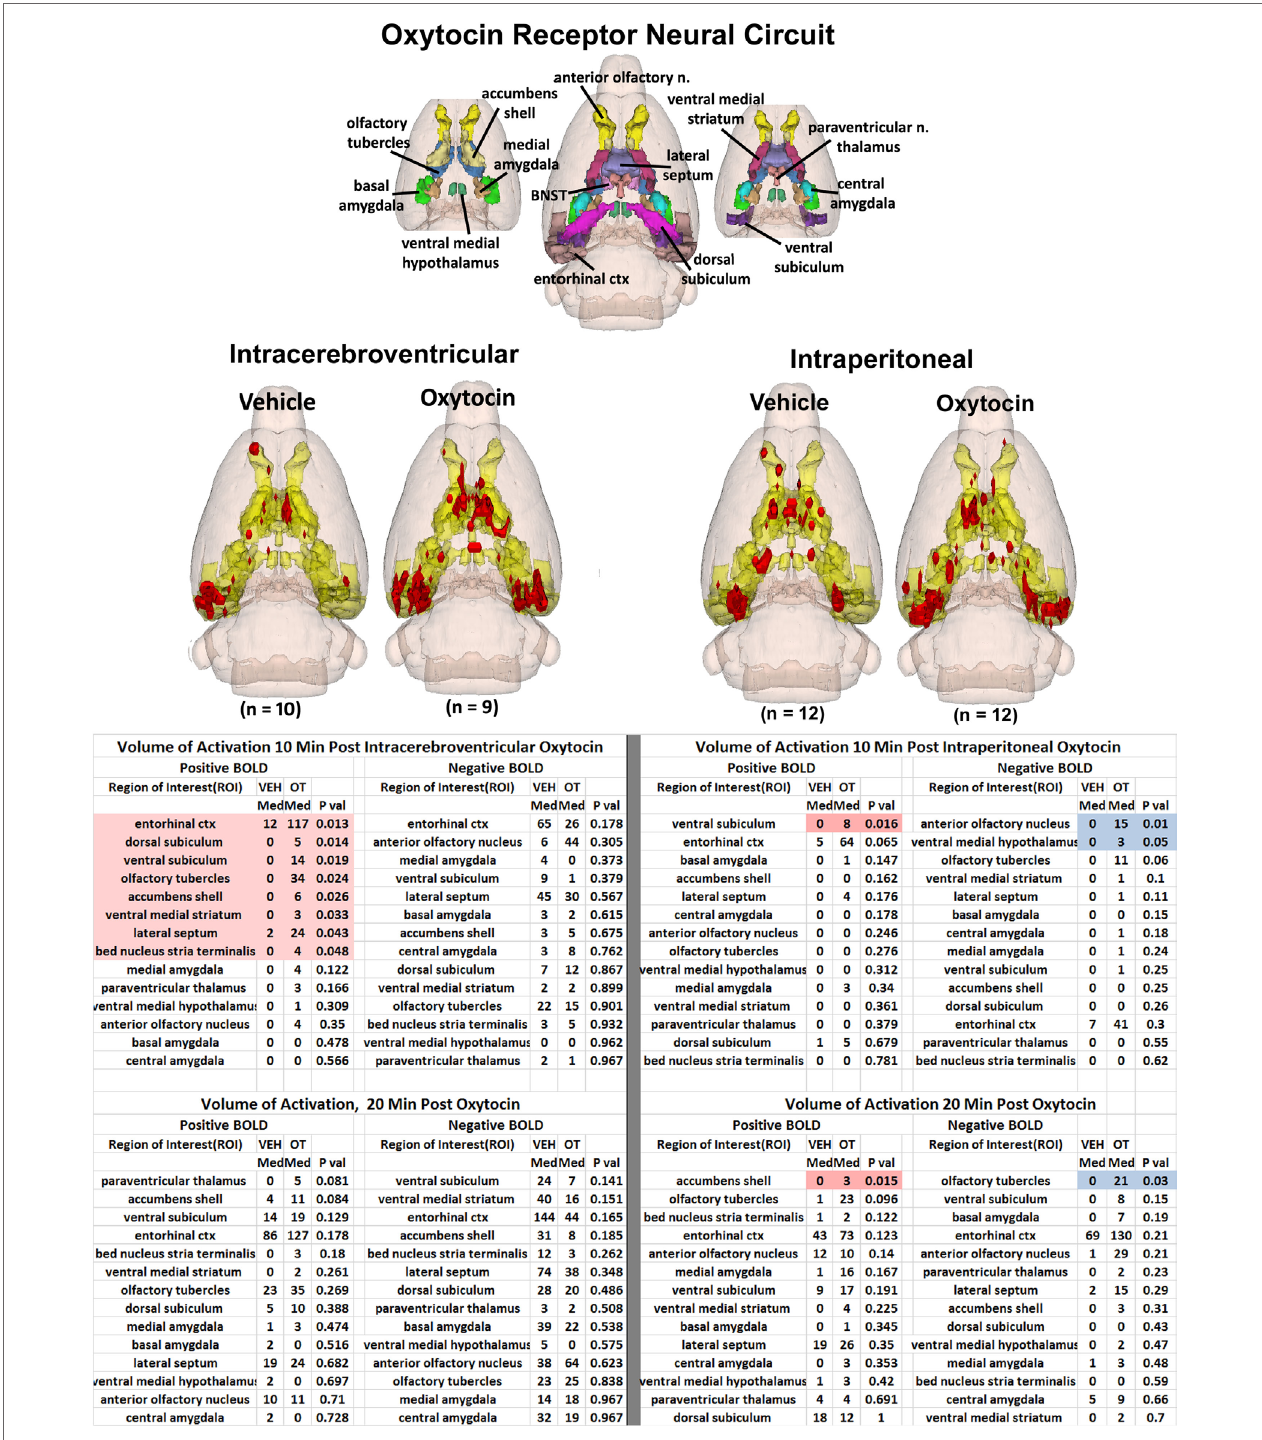
FigUre 2 | neural circuitry of high-density OT receptor binding sites . The 3D color model at the top depicts the location of 14 brain areas in the rat reported to have a high density of OT receptor binding (De Kloet et al., 1985; van Leeuwen et al., 1985; Freund-Mercier et al., 1987; Tribollet et al., 1988). These areas have been coalesced into a single volume (yellow) as shown in the lower 3D images for ICV and IP administrations. Areas in red are the localization of the activated voxels comprising the composite average from the rats in each experimental group. Once fully registered and segmented, the statistical responses for each animal are averaged on a voxel-by-voxel bases. Those averaged voxels that are significantly different from baseline for positive BOLD are shown in their appropriate spatial location. Below are tables of these regions of interest for negative and positive BOLD at 10 and 20 min post ICV and IP OT. All areas are ranked in order of their significance. The brain areas highlighted in red and blue show significant changes in volumes of